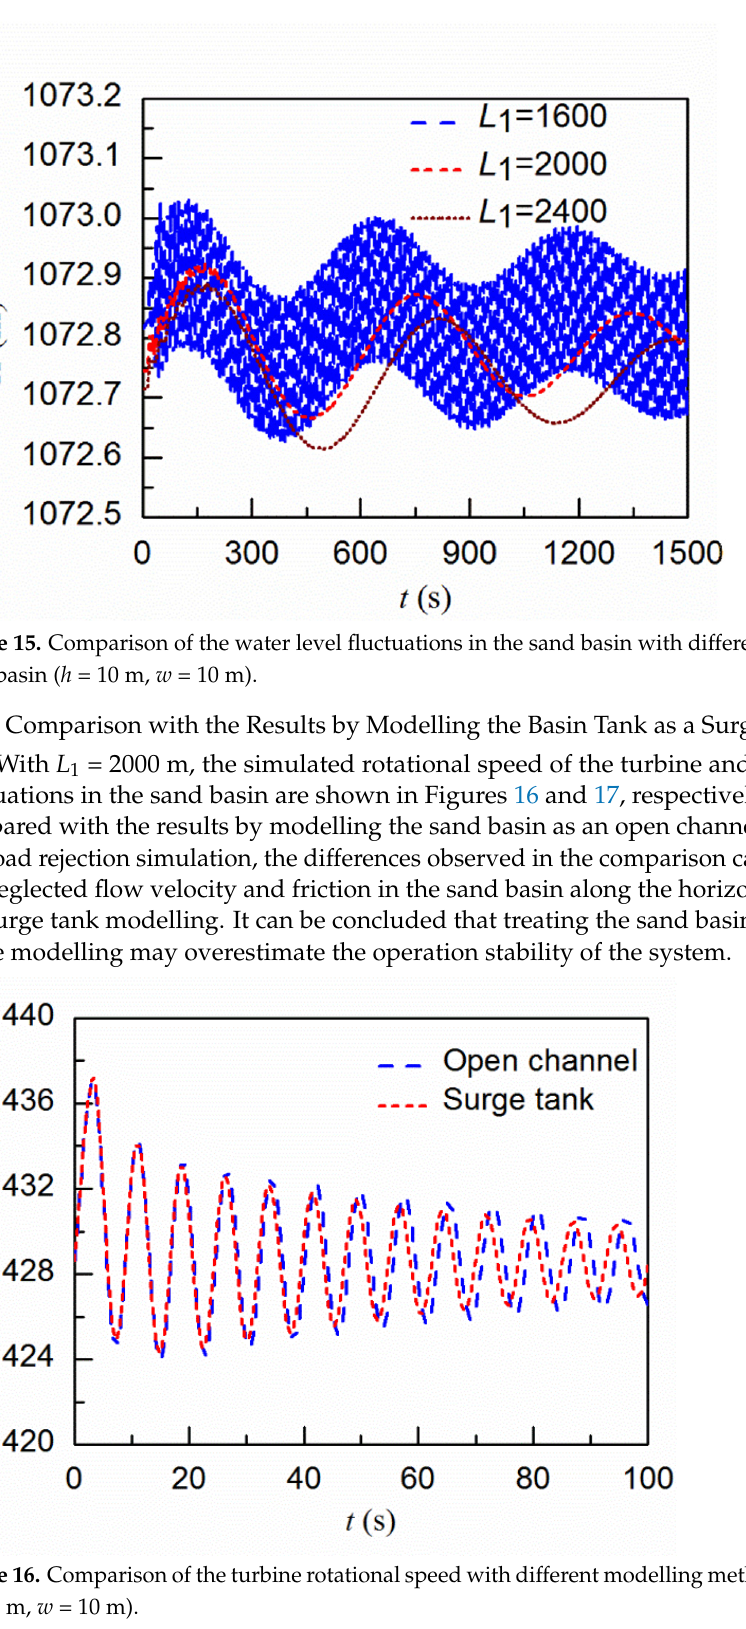
Figure 14. Comparison of the turbine rotational speed with different locations of the sand basin ( h = 10 m, w = 10 m).